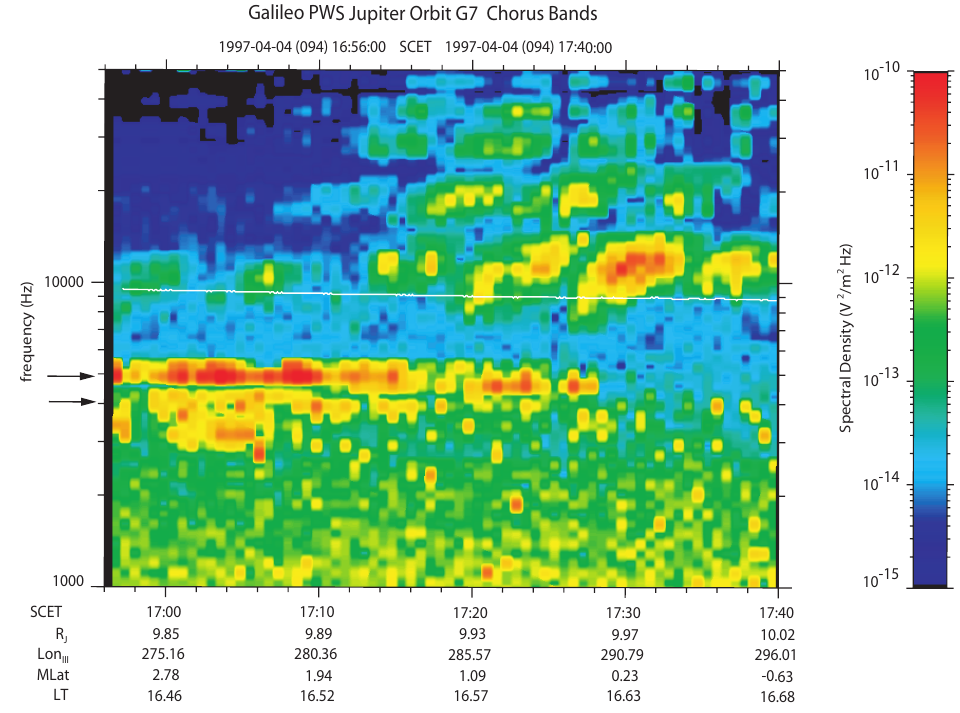
Fig. 2. A smaller time and frequency interval from Fig. 1a. The white line still indicates f ce . Note the upper and lower bands of chorus emission (indicated by arrows) with a band of omission near f ce